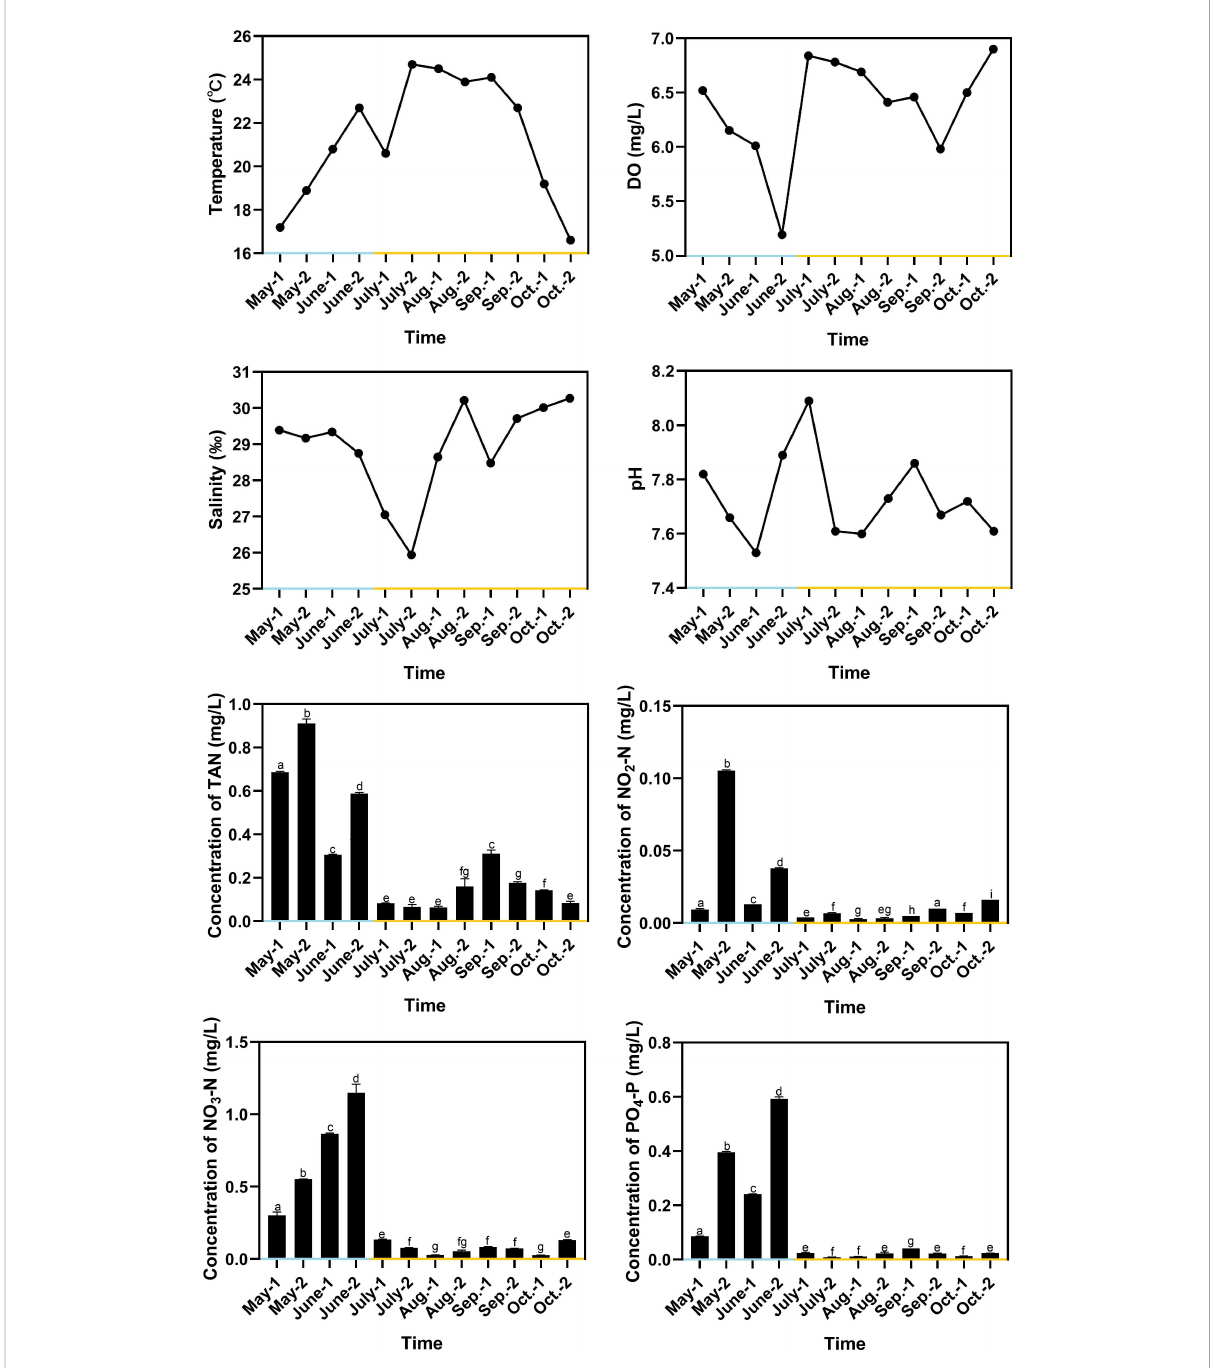
FIGURE 3 Variation of water quality indexes during aquaculture period. Blue x-axis indicates RAS aquaculture period, and yellow x-axis indicates OSCS aquaculture period. The letters above the bars indicate the signi fi cance of differences between groups; the groups with different letters have signi fi cant differences (P <